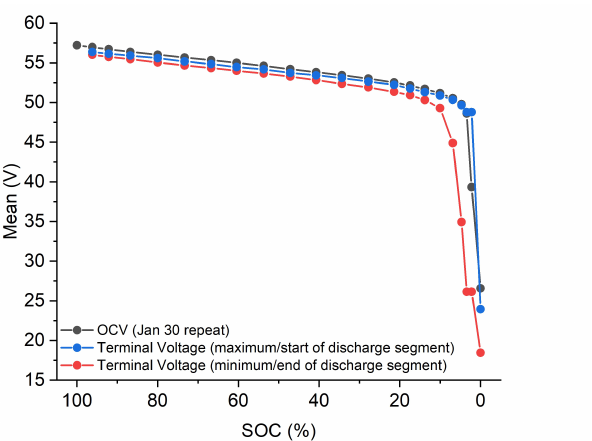
Figure 6. OCV vs. terminal voltage using 20 A max current